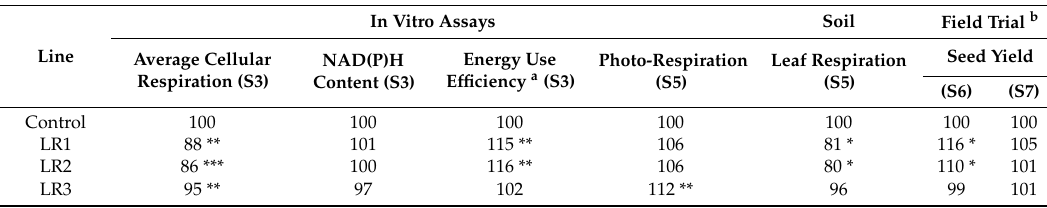
Table 1. Physiological and yield properties of rice